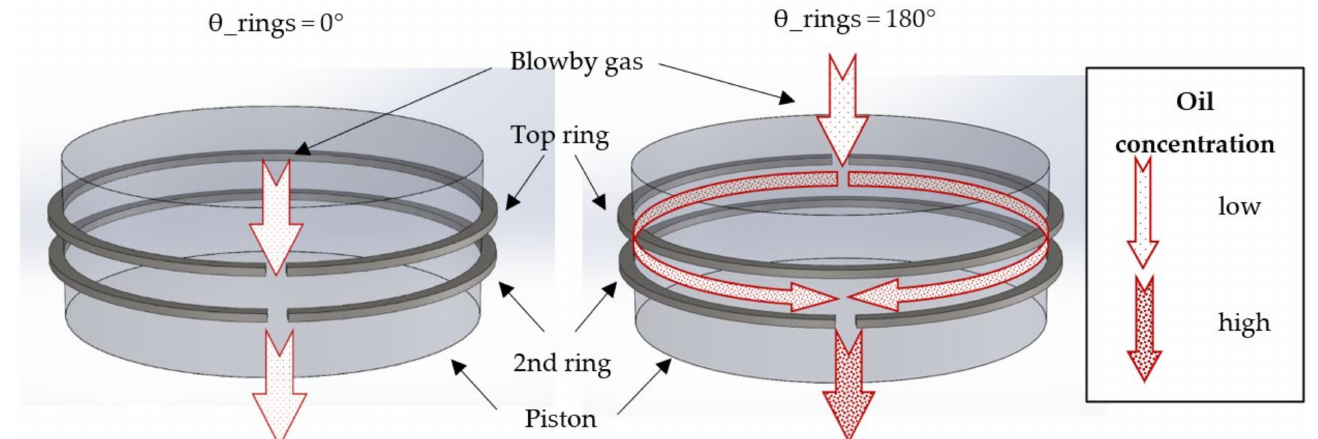
Figure 11. Oil concentration of the blowby gases vs. endgap position of the